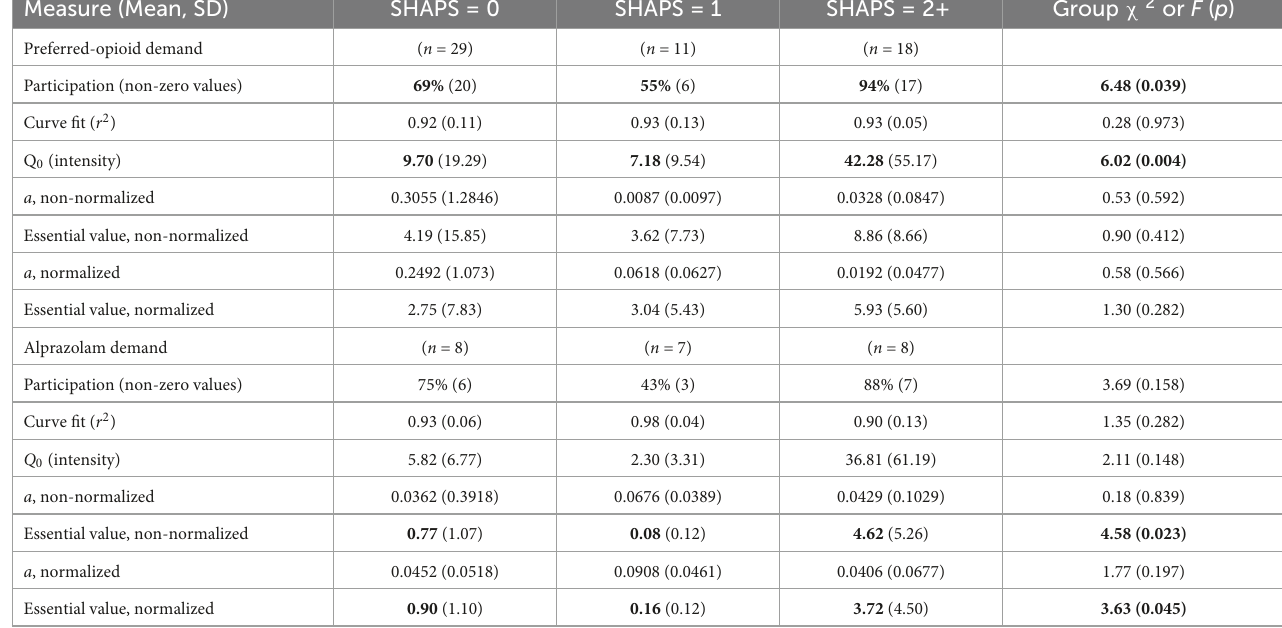
TABLE 2 Parameter estimates for opioid and alprazolam demand, stratified by Snaith-Hamilton Pleasure Scale (SHAPS) anhedonia total